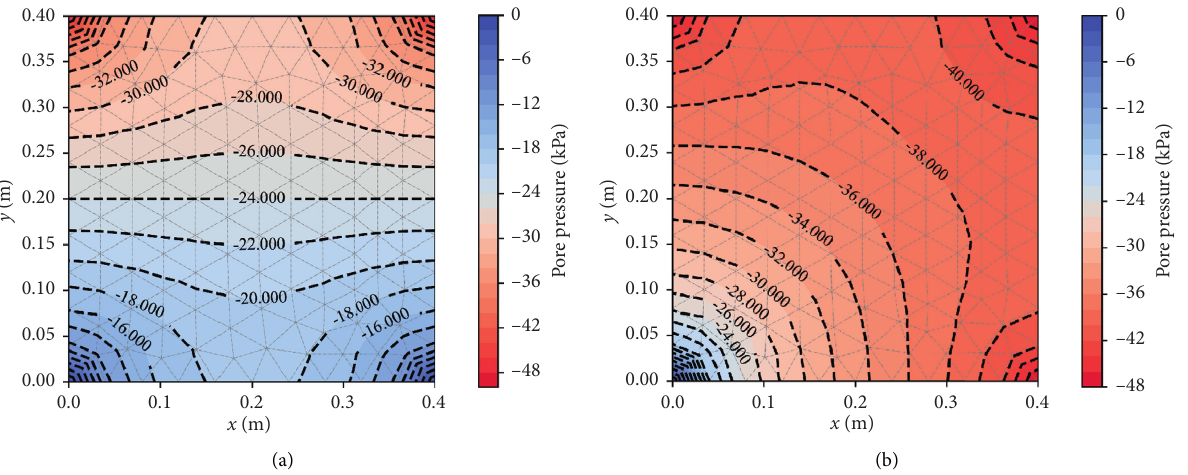
Figure 12: Colormap of excess pore water pressure distribution after electroosmosis. (a) The pore water pressure of the symmetric unit at time 10 8 sec. (b) The pore water pressure of the asymmetric unit at time 10 8